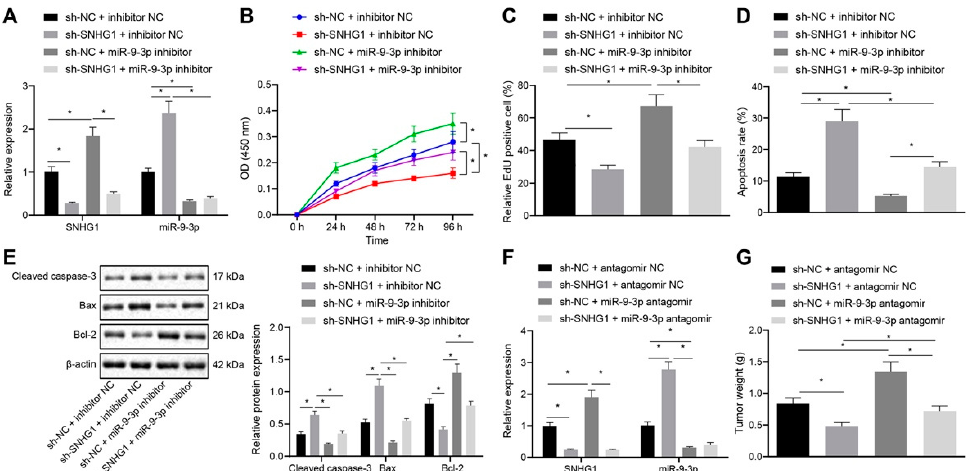
Figure 6. SNHG1 silencing binds to miR-9-3p to repress bladder cancer cell proliferation and tumorigenesis. ( A ) SNHG1 and miR-9-3p expression in T24 cells measured by qRT-PCR. ( B ) CCK-8 assay of the change of T24 cell viability. ( C ) The changes of T24 cell proliferation detected by EdU assay. ( D ) Flow cytometry analysis of the changes of T24 cell apoptosis. ( E ) Western blot analysis of the expression of Cleaved caspase-3, Bax, and Bcl-2 in T24 cells. The stably transfected T24 cells were subcutaneously injected into the axilla of nude mice. ( F ) SNHG1 and miR-9-3p expression in mice measured by qRT-PCR. ( G ) Tumor weight. * p < 0.05. N = 10 mice in each group. The cell experiment was repeated three times. Data were presented as mean ± standard deviation and compared by one-way analysis of variance or repeated measures ANOVA with Tukey’s post hoc